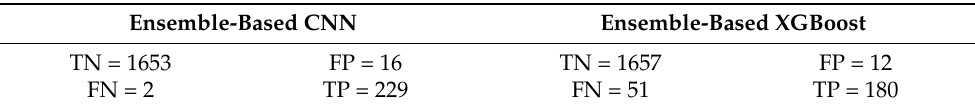
Table 4. Cumulative confusion matrices calculated during the cross-validation for the CNN- and XGBoost-based